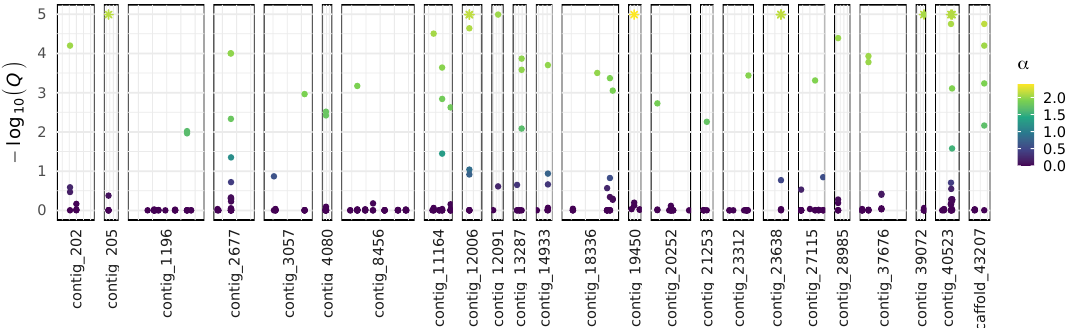
Figure 2. Distribution of SNPs that are associated with altered allele frequencies between populations from North and South of the Main Divide over 24 contigs. 47 SNPs have altered allele frequencies, using the arbitrary Q-value cuto ff of 0.01. α : BayeScan’s locus-specific component of F ST coe ffi cient [44]. Positive values suggest diversifying